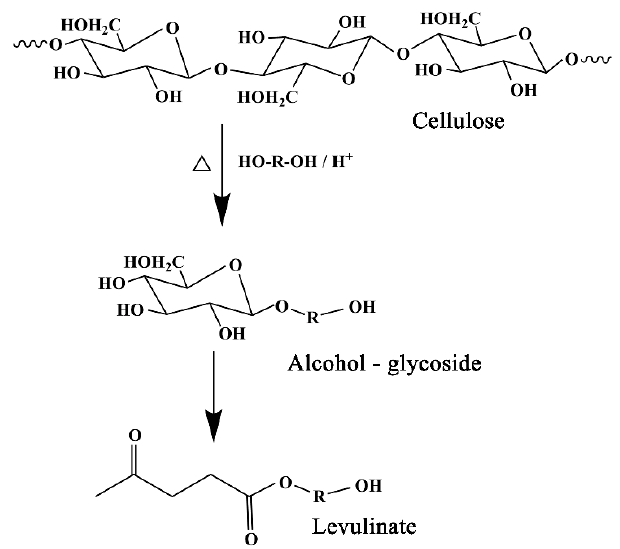
Figure 6. Macromolecular cellulose degradation into small fatty alcohol glycosides. Compared with the spectra of wood powder, the peak of liquefied products varied significantly between 75 and 60 ppm, which indicates that the small molecules of liquefied solvent were involved in the degradation reaction of wood powder, and the lignin degra- dation products of wood powder and the solvent had alkylation reaction. The strong sig- nal peak at 58.5 ppm and 51.0 ppm of chemical shift was attributed to the methoxy group (-OCH 3 ), connected by the side chain of the syringa ring and guaiacol benzene ring. In the spectra of liquefied products, the methoxy signal peaks disappeared at 58.5 ppm and 51.0 ppm, indicating that demethylation reaction occurred in the syringes and the side chains of the guaiacyl benzene rings in lignin. The strong signal peaks with chemical shifts at 173.2 ppm and 19.6 ppm were attributed to the acetyl carboxyl and acetyl methyl groups of hemicellulose, respectively, which were degraded by Arabinoxylan, arabinan, and galacto-glucomannan [25]. In the spectra of liquefied products, the signal peaks at 173.2 ppm and 19.6 ppm disappeared, indicating that hemicellulose was involved in the lique- faction reaction. And when the liquefaction time was 110 min, the hemicellulose had been degraded. It can be seen from the above analysis results that the original chemical structure of poplar wood powder changes to some extent when it is liquefied by poly-hydroxyl alco- hol under acidic conditions, and new compounds are formed. Moreover, there are many types of liquefied products, which are relatively complex. The active intermediates, formed in the process of liquefaction, can be aliphatic alcohols, guaiacol and other com- pounds, which may further be condensed with solvent small polyols or with each other to produce condensates with relatively large molecular weights such as polyether polyols, resulting in a difference between the liquefaction product structure and the structure of the wood powder. 3.1.3. Hydroxyl Value and Acid Number of Liquefied Products As can be seen from Figure 7, with the liquefaction time from 0 to 110 min, the hy- droxyl value of the wood powder liquefaction product first decreased and then increased, reaching a maximum value of 1042 mg KOH/g at 110 min. This is because, before 50 min, the liquefaction time is short, and the liquefaction reaction is dominated by the degrada- tion of lignin [26,27], resulting in the generation of intermediates with active points [28]. Thus, the number of hydroxyl groups decreases and the hydroxyl value decreases.